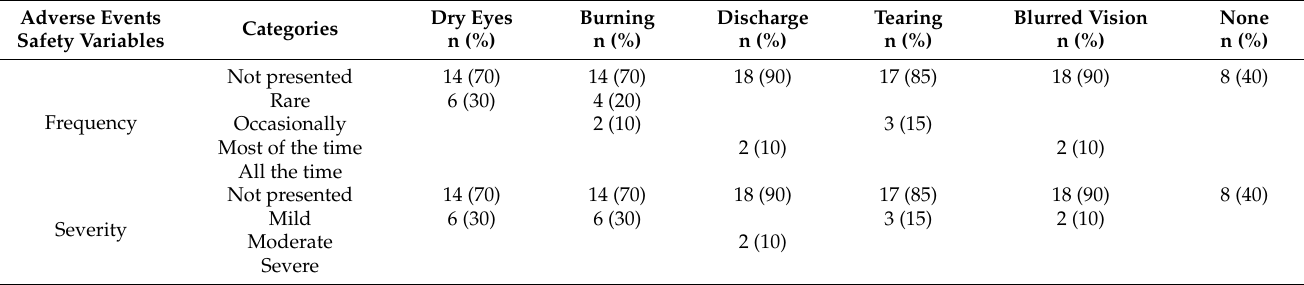
Table 3. Adverse events reported in healthy subjects treated with triamcinolone acetonide-loaded liposomes